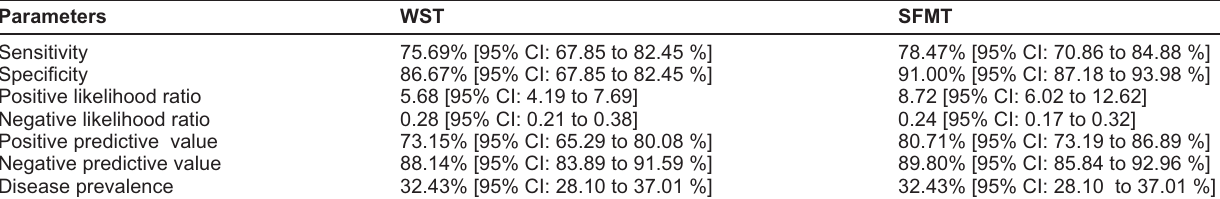
Table-4: Sensitivity, specificity, predictive value, likelihood ratio and disease prevalence of WST and SFMT using CMT as a gold standard